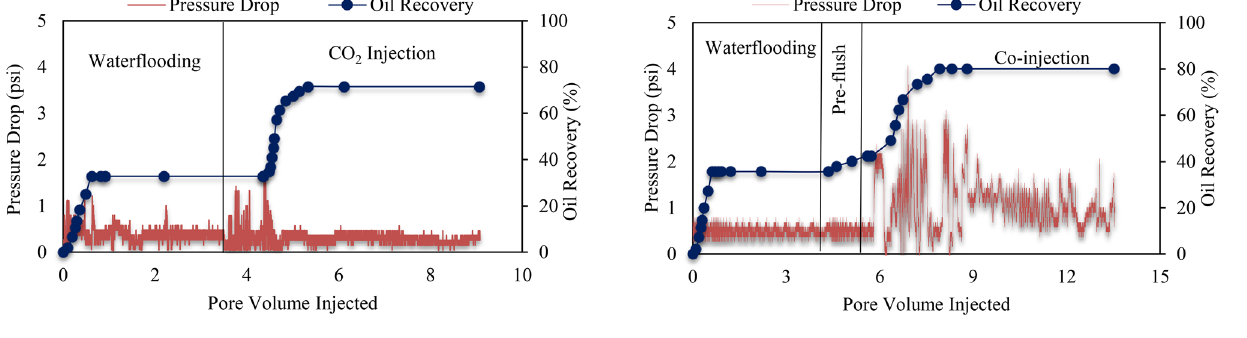
Fig. 5 Oil recovery following waterflooding and foam injection for a 2 injection, non- mixture of surfactant and NPs, non-fractured